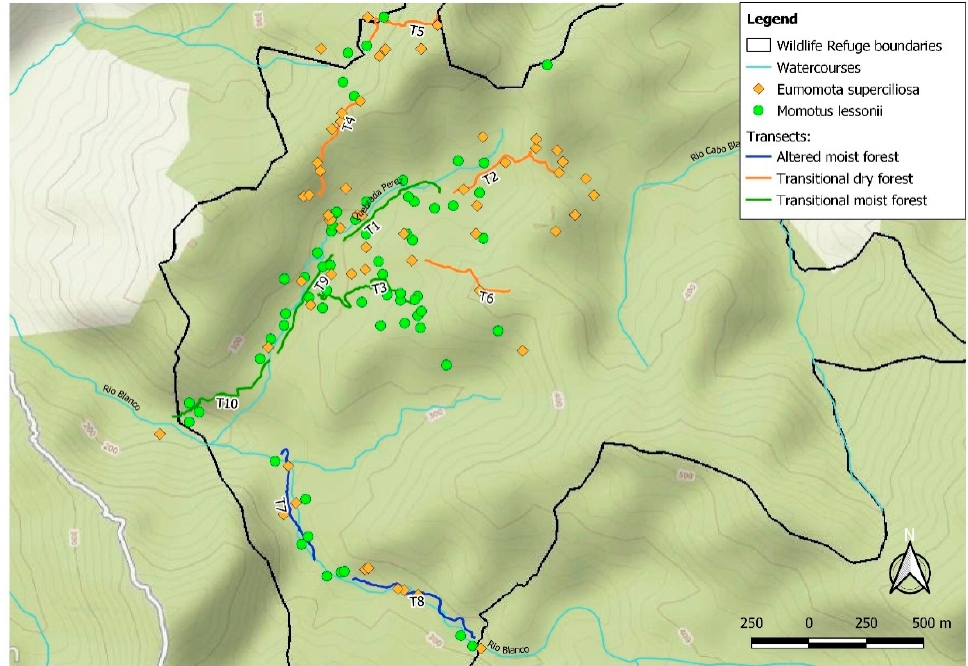
Figure 3. Map showing all the records of the two species of Momotidae within the Karen Mogensen Wildlife Refuge. Transects covered are coded T1 through T10 and colored differently according to the habitat crossed. Map source: Komoot maps.